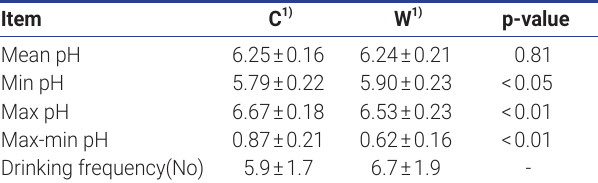
Table 5. Comparison of lactation performance between conventional farm and welfare farm for 3 days Items